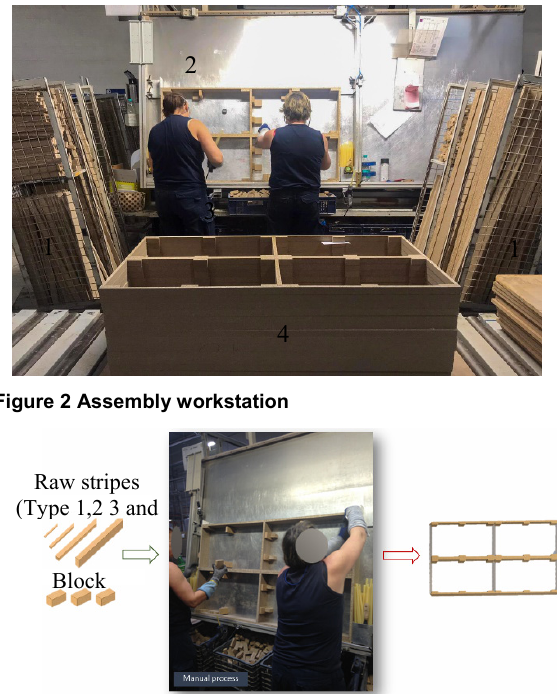
Figure 3 Initial assembly workflow (inputs, example of posture adopted,